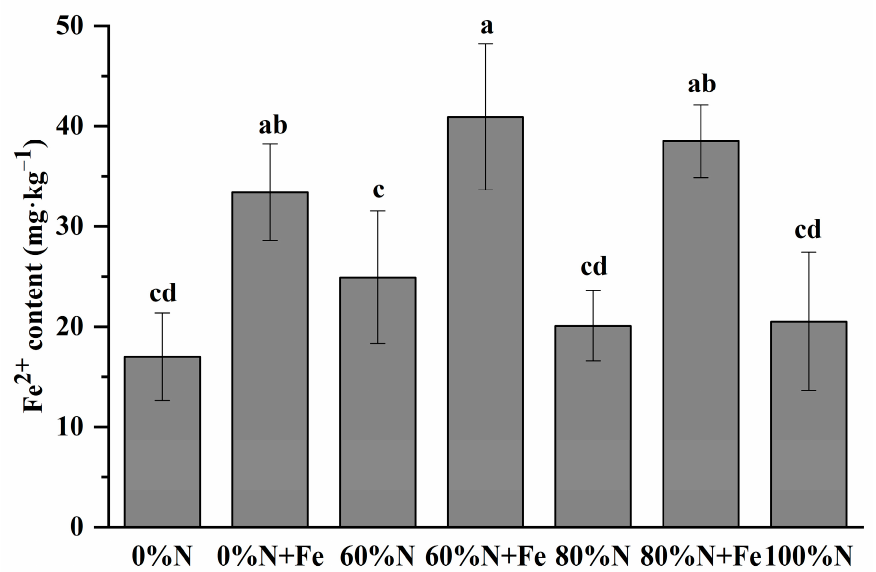
Figure 1. Fe 2+ content of soil under various nitrogen fertilization rates with or without iron amend- ment in 2020. Conventional N fertilization rate (315 kg N hm − 2 season − 1 ) for rice in lower Yangtze River Delta is 100%N. Fe was applied at 5000 kg hm − 2 as iron powder (>99% purity) when the field experiment was initiated. Treatments that have the same letter above their bars (means ± SD, n = 4) are not significantly different at p < 0.05 as determined by analysis of variance (one-way ANOVA), followed by least significance difference (LSD) post hoc